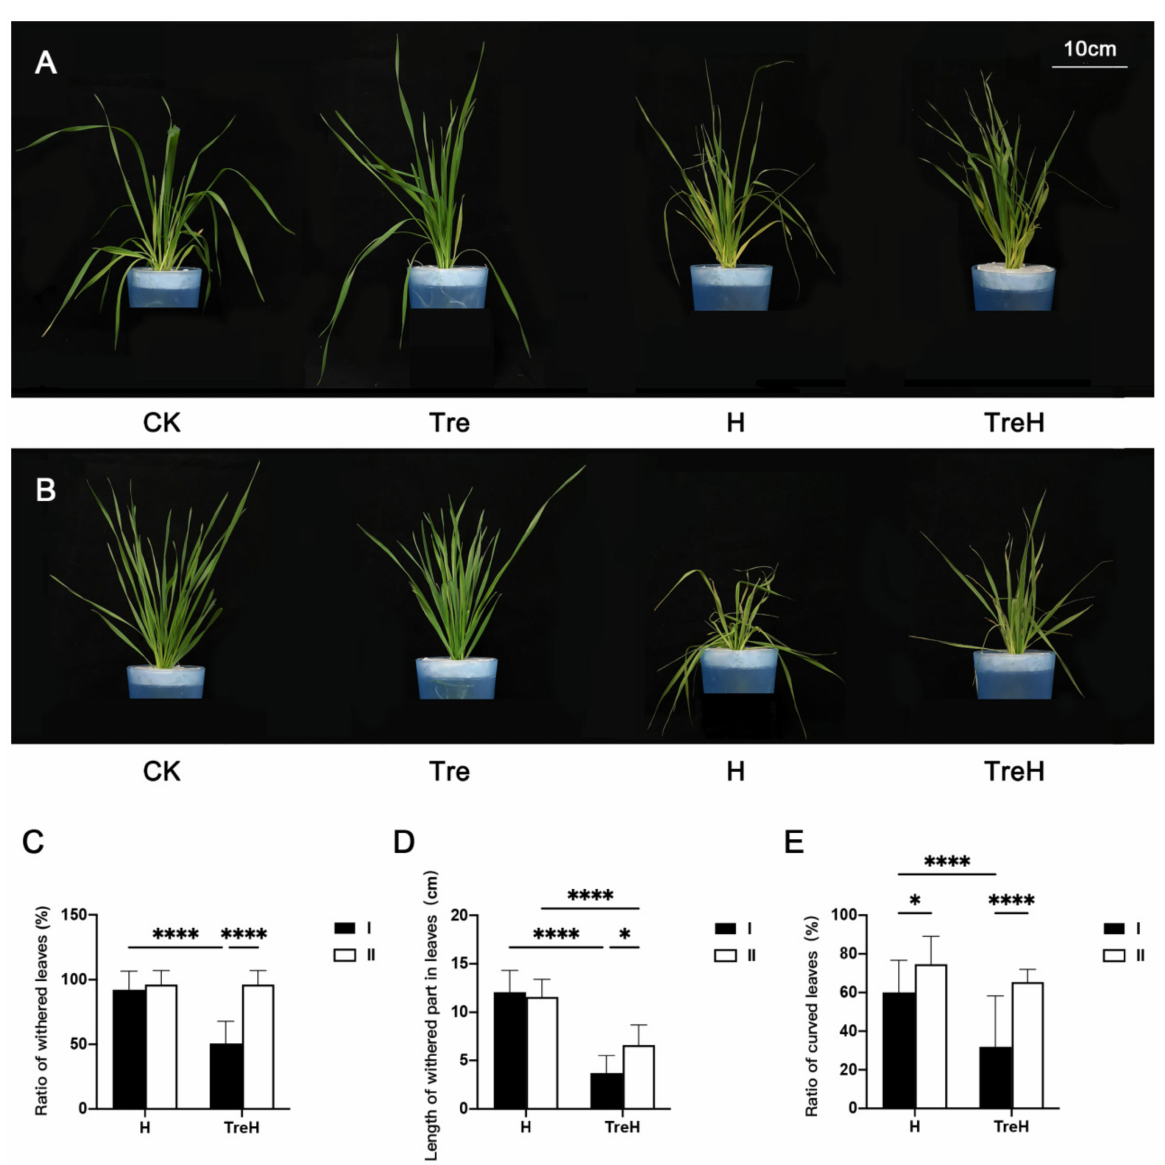
Figure 1. Phenotypic changes of wheat induced by exogenous trehalose under heat stress. ( A ) Yangmai 18. ( B ) Yannong 19. CK—control group; H—heat stress treatment for 24 h; Tre—trehalose pretreatment for 3 d; TreH—trehalose pretreatment for 3 d followed by high- temperature treatment for 24 h. A total of plants were randomly selected from each treatment group for taking photos. All the photos were taken soon after the high-temperature groups finished the heat-stress treatment. ( C ) The ratio of withered leaves in wheat seedlings. ( D ) Length of withered part in leaves. ( E ) The ratio of curved leaves in wheat seedlings. I—Yangmai 18; II—Yannong 19; H—heat stress treatment for 24 h; TreH—trehalose pretreatment for 3 d followed by high-temperature treatment for 24 h. Values are the means ± SDs ( n = 3). * indicates a significant difference at 0.01 < p ≤ 0.05, **** indicates a significant difference at p ≤